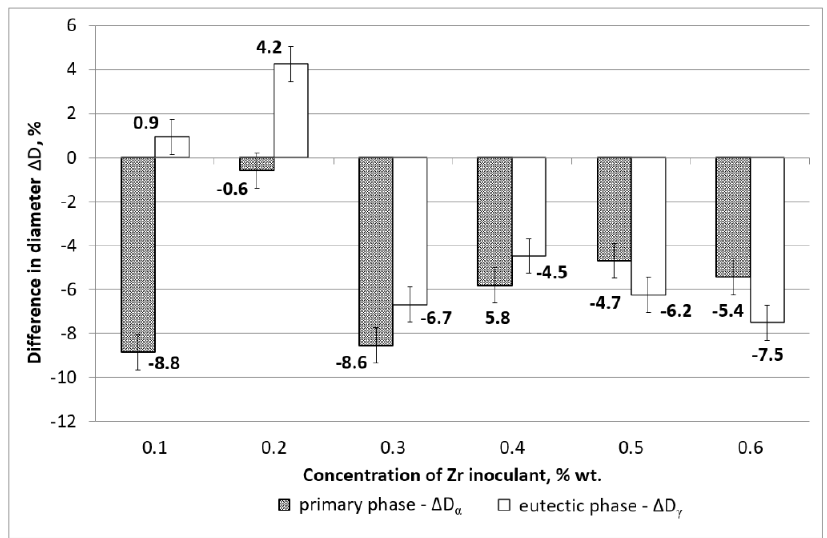
Figure 6. Change in the mean diameters of phase α Mg and α Mg + γ (Mg 17 Al 12 ) in inoculated samples in reference to AZ91 baseline alloy. in reference to AZ91 baseline alloy.